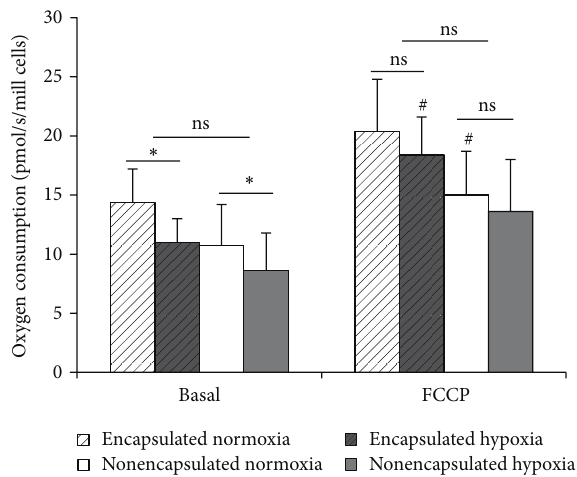
Figure 2: Effect of hypoxia and encapsulation on oxygen consump- tion. ∗ 𝑃 < 0.05 for the effect of hypoxia and # 𝑃 < 0.05 for the effect of FCCP versus basal respiration. Data are mean ± SEM of five-six separate experiments (one-three parallels per experimental condition), one-two experiments per donor (four